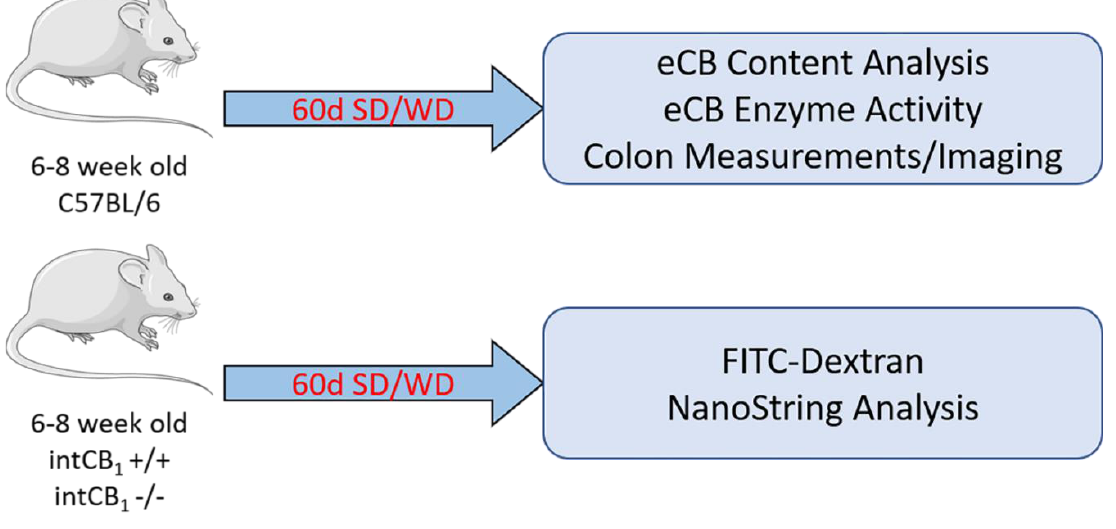
Figure 1. Experimental design. Male wild-type (WT), intCB1−/− , and intCB1+/+ mice were placed on a SD or a WD for eight weeks. Levels of endocannabinoids (eCBs) and activity of their metabolic enzymes were analyzed in WT mice (top panel), and gut-barrier function and analysis of expression of genes associated with gut barrier function and inflammation was performed on SD- and WD-fed intCB1+/+ control mice and intCB1−/− mice (bottom panel). SD = standard diet, WD = Western diet, intCB1−/− = conditional intestinal epithelial cannabinoid receptor subtype-1 deficient mice.